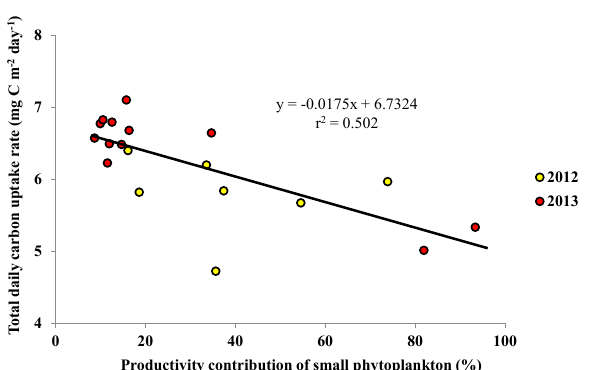
Figure 7. Relationship between productivity contributions (%) of small phytoplankton and the total daily carbon uptake rates (mgCm − 2 d − 1 ) of phytoplankton (large + small). The total daily carbon uptake rates were transformed into natural logs for a linear regression. Red circles represent data obtained in 2013 (this study). Yellow circles representing 2012 data (unpublished) were included for a better